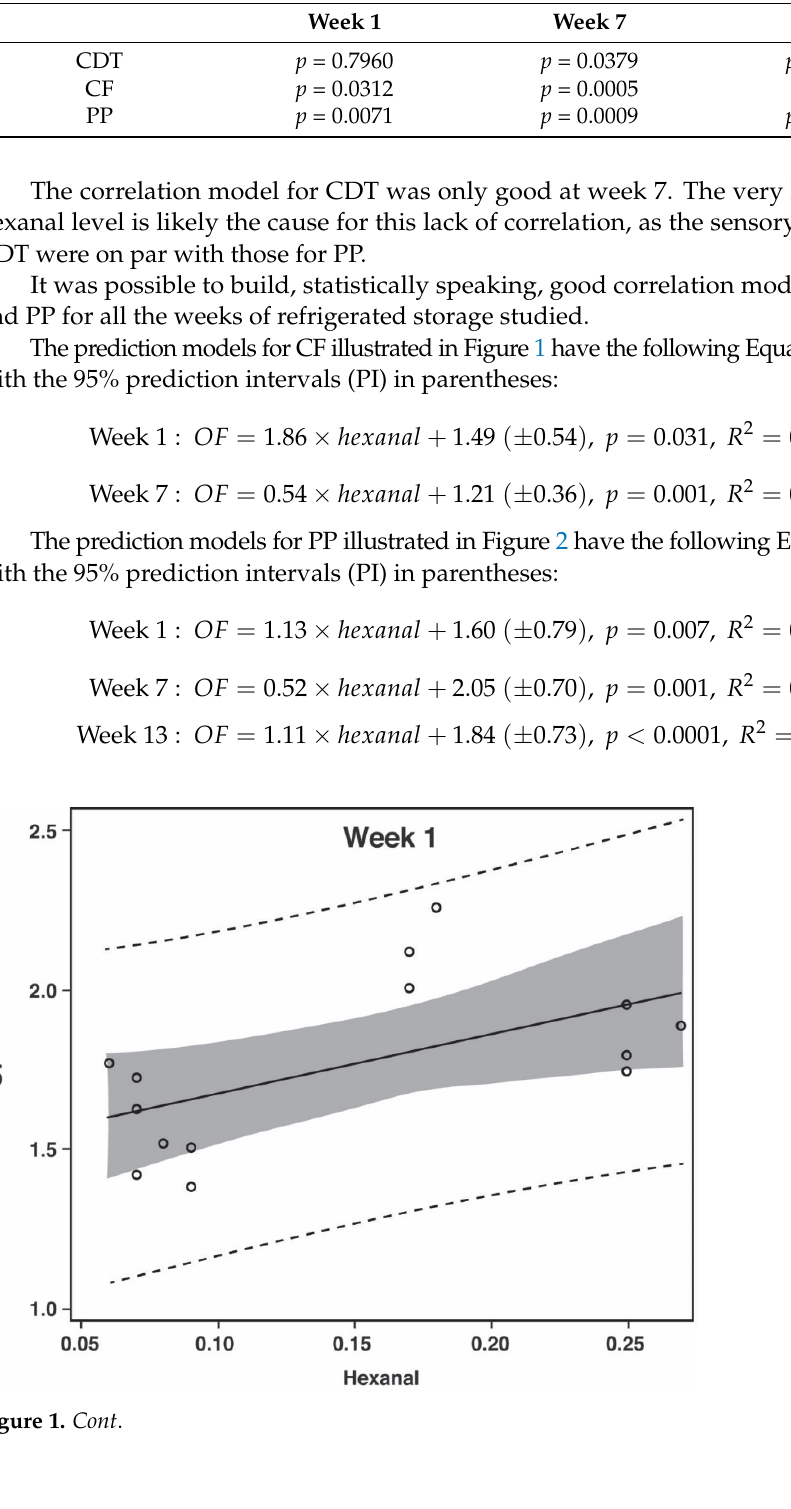
Table 4. Significance of correlation between headspace hexanal and oxidation flavor for cured deli turkey (CDT), chicken fillet (CF), and pulled pork (PP) after 1, 7, and 13 weeks of refrigerated storage. — indicates that no measurements were done for CF at week 13. Significance of Correlation between Hexanal and Oxidation Flavor